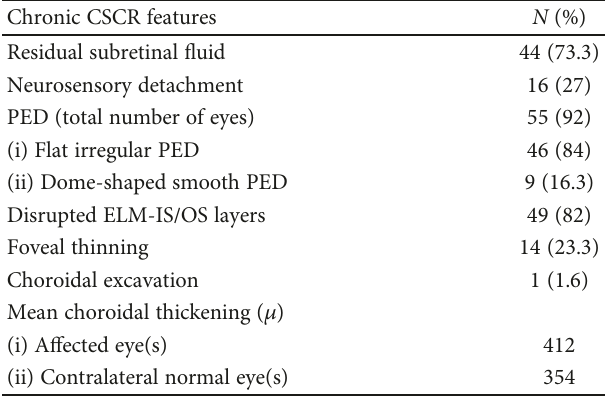
Table 2: Chronic CSCR features in the study population. Table 3: Relative contribution (%) for studied chronic CSCR features in CNV